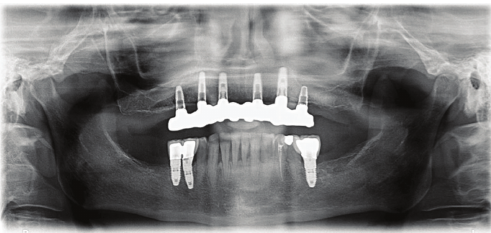
Figure 7: Panoramic radiograph 30 months after